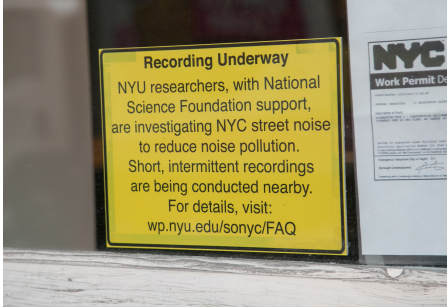
Figure 3. Street-level signage mounted in close proximity to sensor node location for public